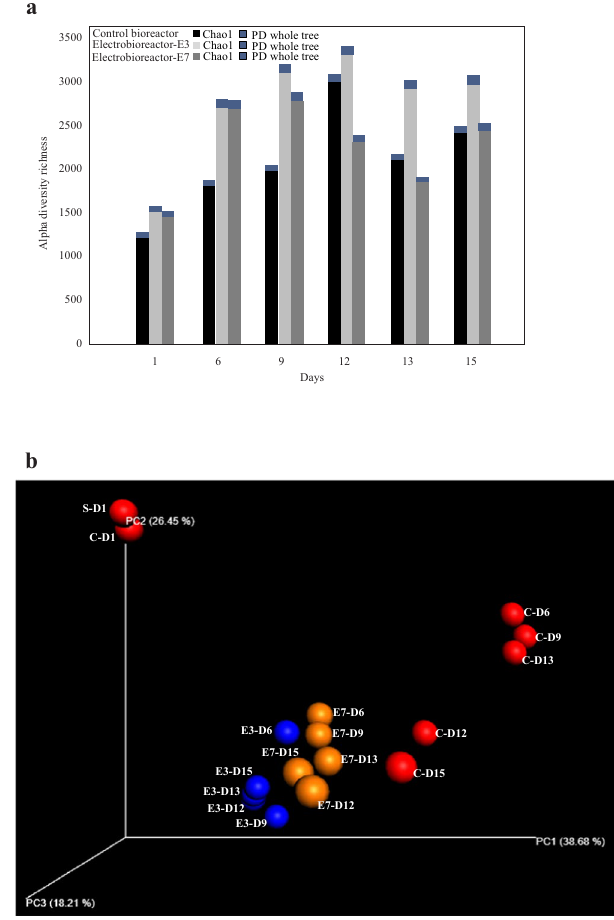
Figure 2. ( a ) Alpha diversity richness calculations using Chao1 and PD whole tree methods, ( b ) three- dimensional principal coordinate analysis (PCoA) plot showing the bacterial community variations present in serially passaged control bioreactors (red data points) and electro-bioreactors E3 (blue data points) and E7 (orange data points). It is noted that bacterial communities in electro-bioreactors clustered together when compared to control bioreactor. (S-D1: Fresh sludge sample without feeding with synthetic wastewater; C-Di: Control sample in day i; E-Dj: Electro-bioreactor sample in day